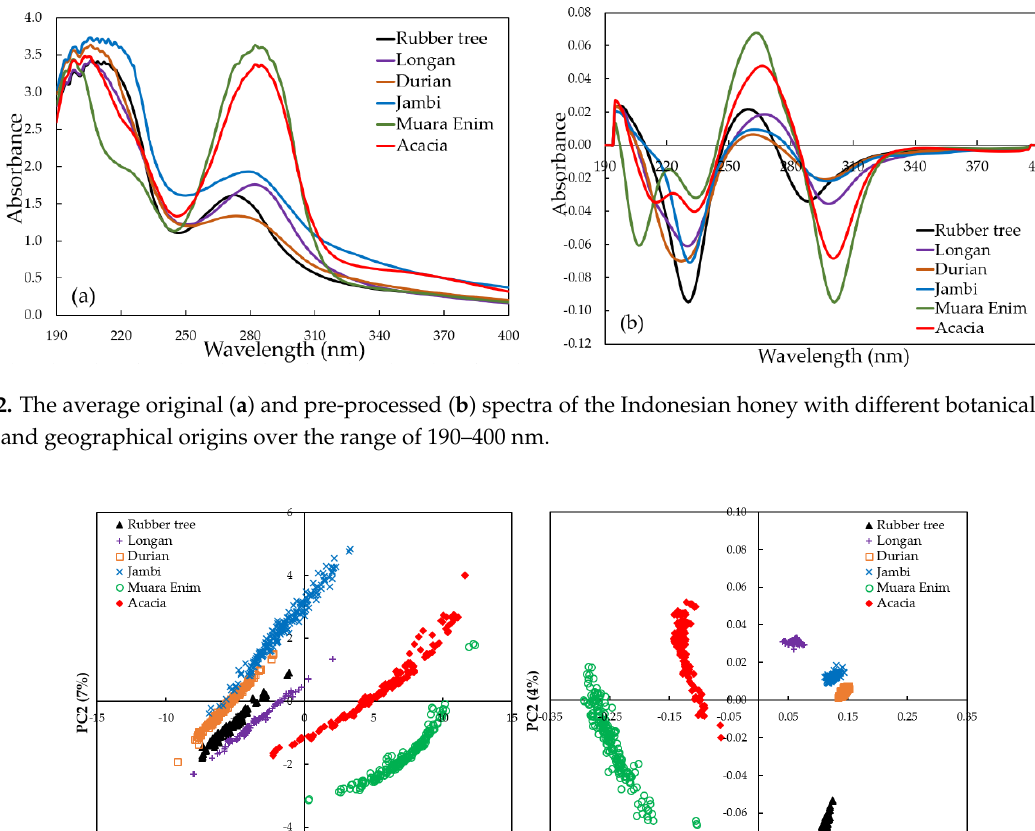
Figure 2. The average original ( a ) and pre-processed ( b ) spectra of the Indonesian honey with different botanical, entomo- logical, and geographical origins over the range of 190–400 nm.